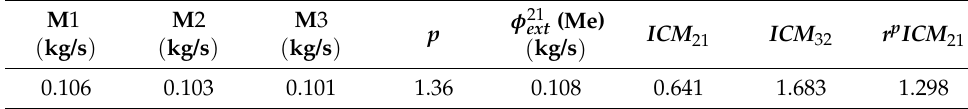
Table 5. Results of the study of mesh convergence for the oil mass flow rate at the oil outlet.